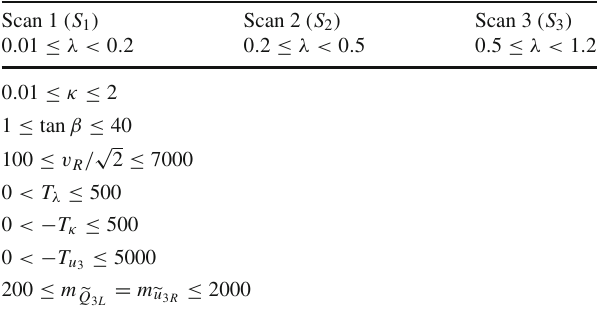
Table1 Rangeoflow-energyvaluesoftheinputparametersinEq.(58) that are varied in the three scans, where tan β is a flat prior whereas the others are log priors. The VEVs v R , and the soft parameters T λ , T κ , T u = m ˜ m ˜ u 3 R are given in GeV Q 3 L